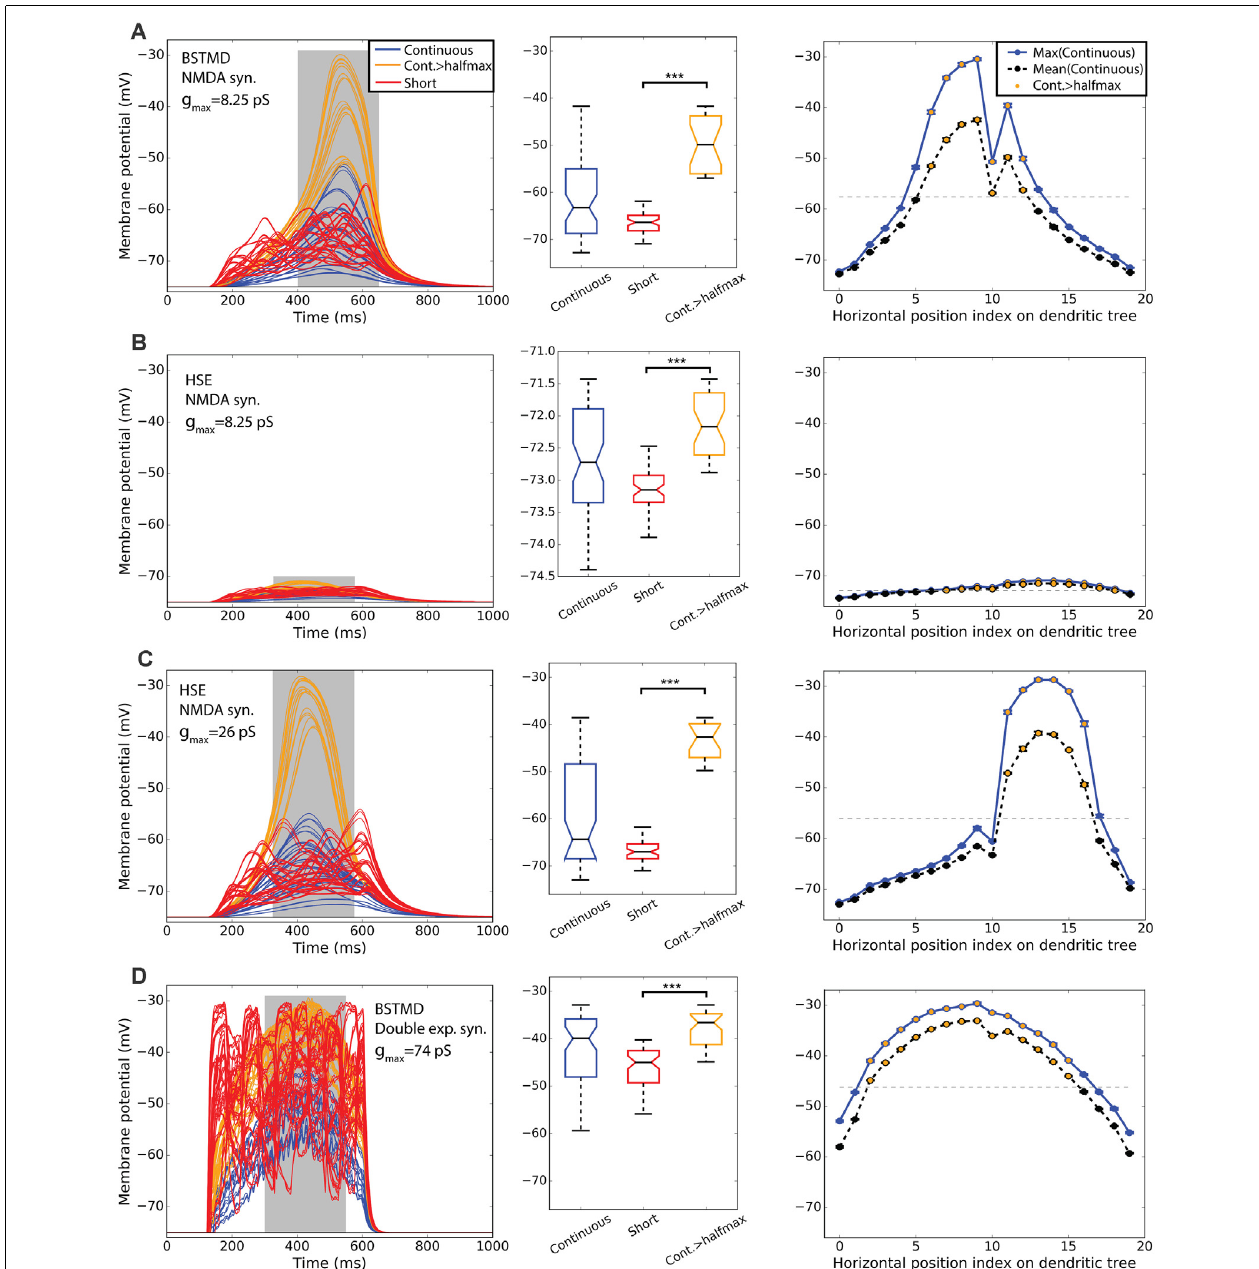
FIGURE 4 | BSTMD1 and HSE simulations indicate the difference in bimodality. Row (A) shows BSTMD1 simulations. Panels (B,C) show HSE simulations, one with the same synaptic gain ( g max ) as the BSTMD1 simulation and one with higher synaptic gain. Panel (D) shows BSTMD1 simulations with double exponential (exp2syn) synapses instead of NMDA synapses. The left column shows the membrane potential over time. The middle column shows a box plot of the average membrane potentials of the curve area marked in gray in the left column. The right column shows the average maximum (entire curve) and average (from gray area) membrane potentials (and SEM) of three identical trials differing only in randomness from spike input generation. The SEM is close to the data point marker due to low variance between trial repeats. ∗∗∗ (A) : p = 1.12 ∗ 10 − 11 ( n cont = 21, n short = 60), (B) : p = 8.52 ∗ 10 − 14 ( n cont = 36), (C) : p = 1.52 ∗ 10 -10 ( n cont = 18), (D) : p = 8.08 ∗ 10 − 13 ( n cont = 42). The median difference for Cont.>halfmax vs. short is (A) 16.49, (B) 0.98, (C) 24.35 and (D) 8.37 (mV).